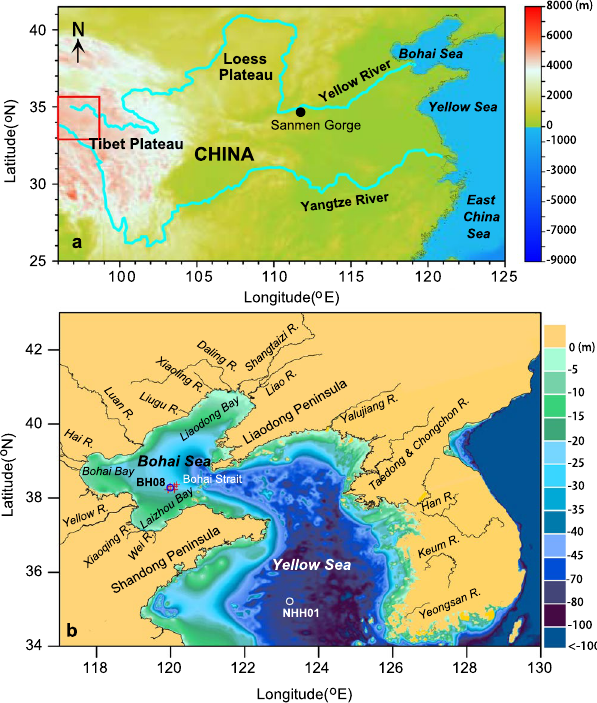
Figure 1. Map showing the Yellow River and location of sediment cores (circles) investigated in this study. ( a ) Geomorphology of China showing the entire course of the Yellow River. ( b ) Locations of core BH08 in the Bohai Sea and core NHH01 in the Yellow Sea, as well as main rivers flowing into the Bohai Sea. Surface samples 30 close to the core BH08 site (red crosses) were selected to examine the clay minerals for comparison. The red square in panel ( a ) indicates the origin region of the Yellow River and Yangtze River. The base map ( a , b ) was generated using the software Surfer (V.13; http://www.goldensoftware.com) and DEM data from http://